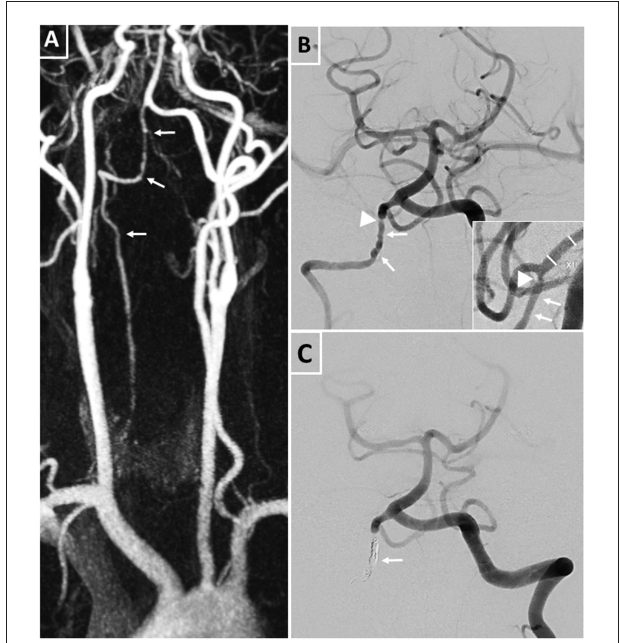
FIGURE 2 | Pre- and post-interventional images of the right dysplastic vertebral artery and its multifocal stenoses. (A) MRA displaying the right vertebral artery with multiple intra- and extracranial irregularities (tailed arrows) corresponding to the diagnosis of a dysplastic vertebral artery. (B) Pre-interventional digital subtraction angiography of the posterior circulation with irregularities (tailed arrows) and distal stenosis of the vertebral artery (arrow head) proximal to the outflow of the right posterior inferior cerebellar artery in two plains. (C) Post-interventional digital subtraction angiography of the posterior circulation after coil occlusion of the right V4 segment (tailed arrow) with preservation of the right posterior inferior cerebellar artery outflow.